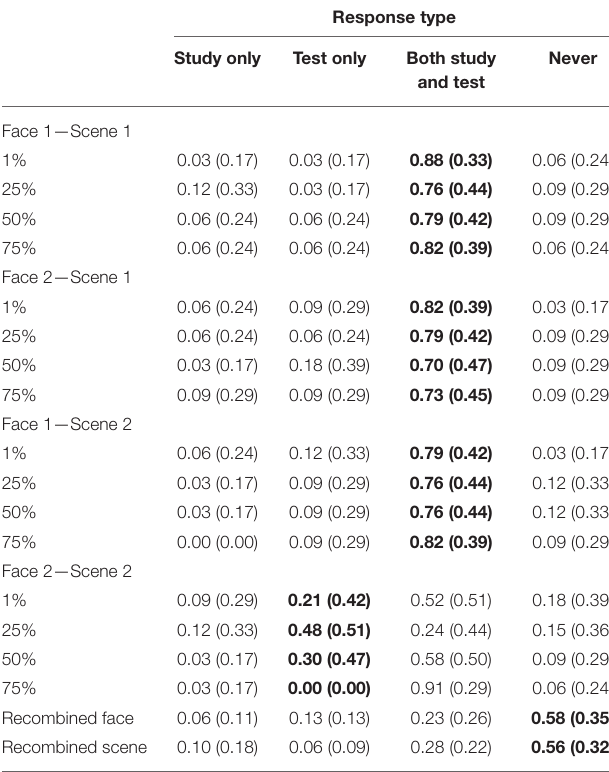
TABLE 5 | Experiment 3 source memory responses separated by shared parent blend level and trial